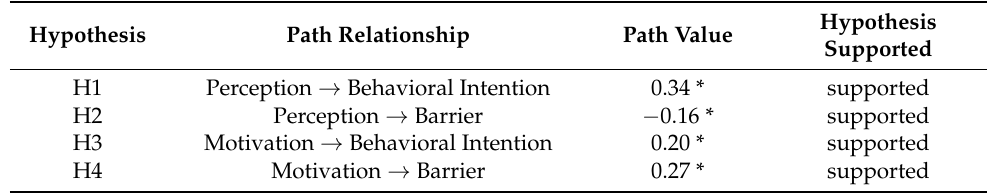
Table 8. Empirical results of the research hypotheses.